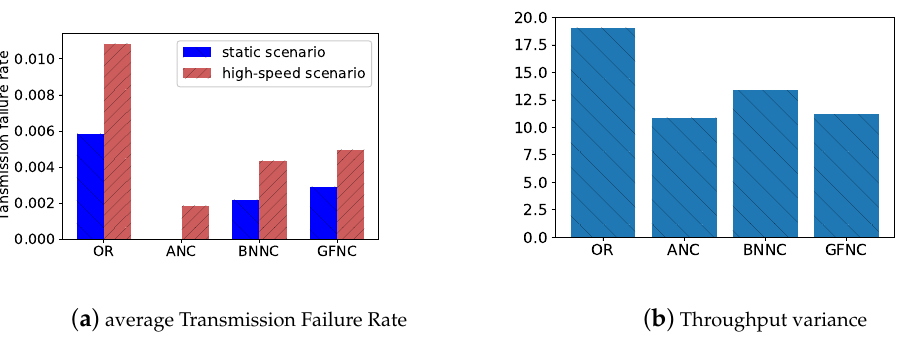
Figure 10. The real-time throughput performance of different schemes in high-speed and static scenarios: ( a ) The real-time throughput performance of different network coding schemes in the static scenario; ( b ) The real-time throughput performance of different schemes in the high-speed scenario.